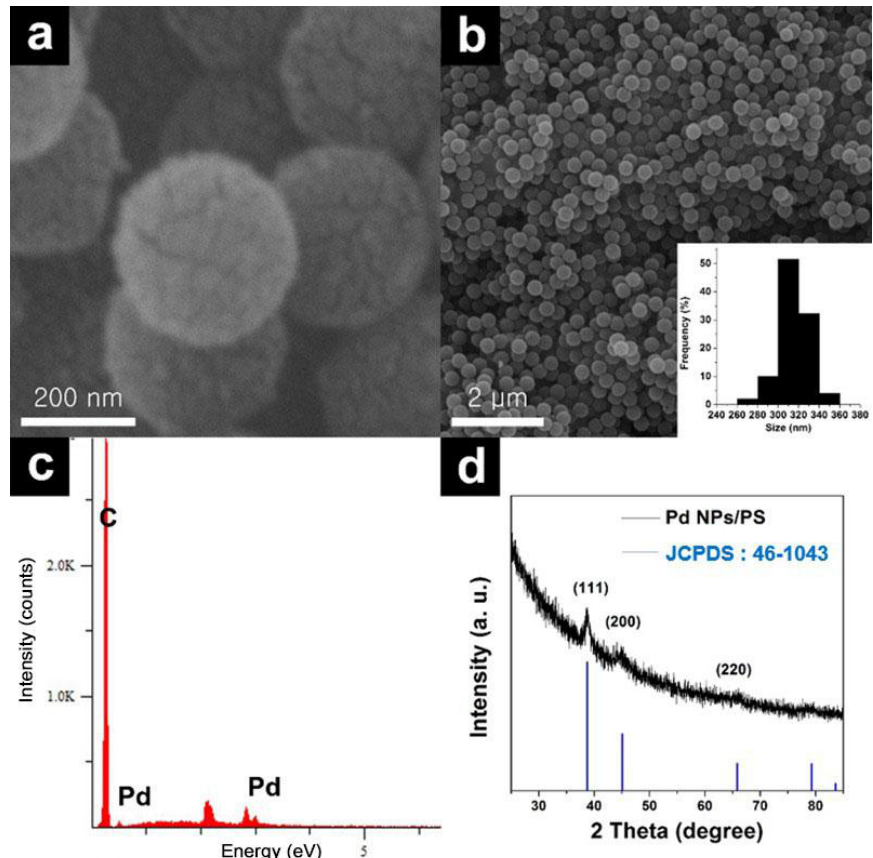
Figure 2. High- and low-resolution ( a , b ) SEM images of Pd/PS spheres. EDS spectrum ( c ) and XRD patterns ( d ) of Pd/PS spheres. The insert in ( b ) is the size distribution of Pd/PS spheres. The Pd/PS@ZIF-8 core-shell nanocomposite was prepared by a solvothermal approach. The